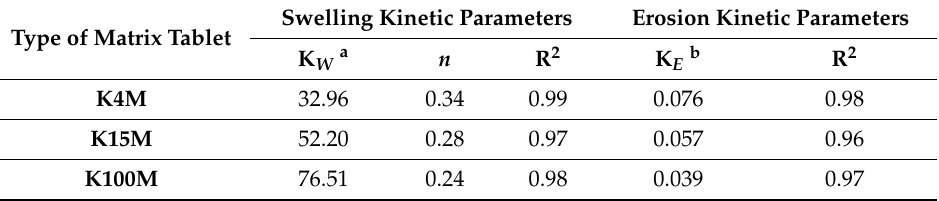
Figure 8. HPMC dissolution vs. time profile of 3D printed HPMC matrix tablets. 3.3.2. Drug Release Studies Initially, HPMC forms a gel on the surface of the matrix tablets after getting hydrated on contact with the dissolution medium. Progressive contact with the medium leads to subsequent bulk